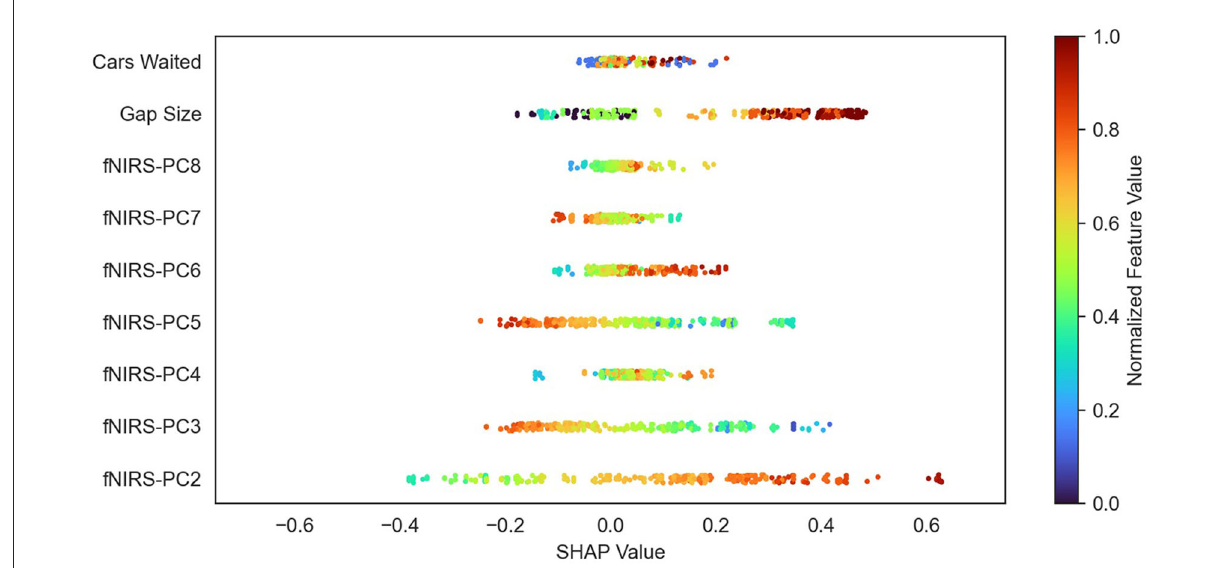
FIGURE8 Beeswarm plot of the feature importance analysis of one subject. Each dot represents one sample of the test dataset. SHAP values for each of these samples are represented by their value on the x -axis. The normalized feature values of each sample are color-coded. Note how the feature values vary systematically in the features with high average SHAP